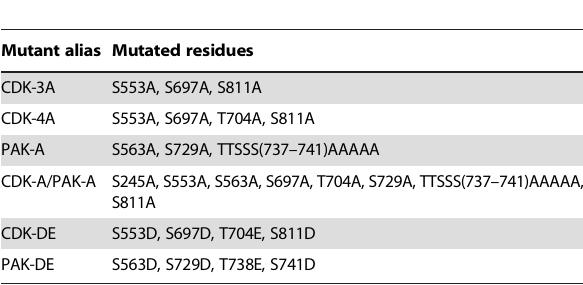
Table 1. Mutation of CDK or PAK consensus sites.